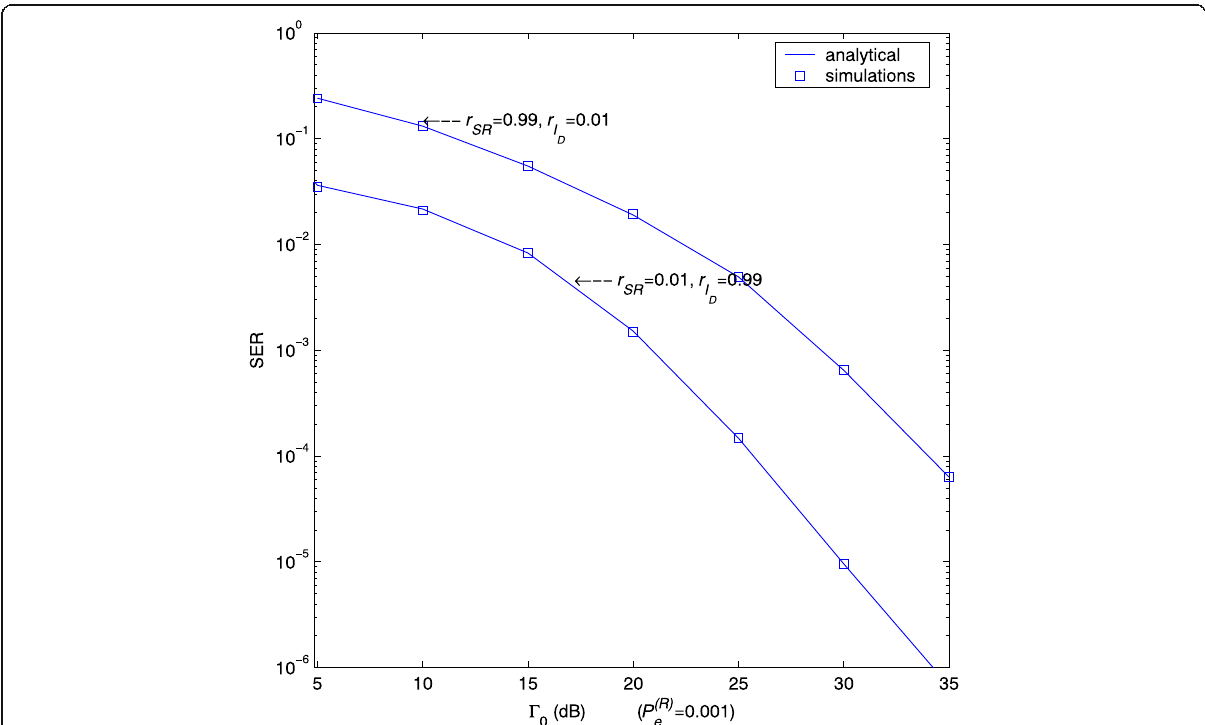
¼ 2, Γ total ¼ 10 dB, γ Th = 1 D